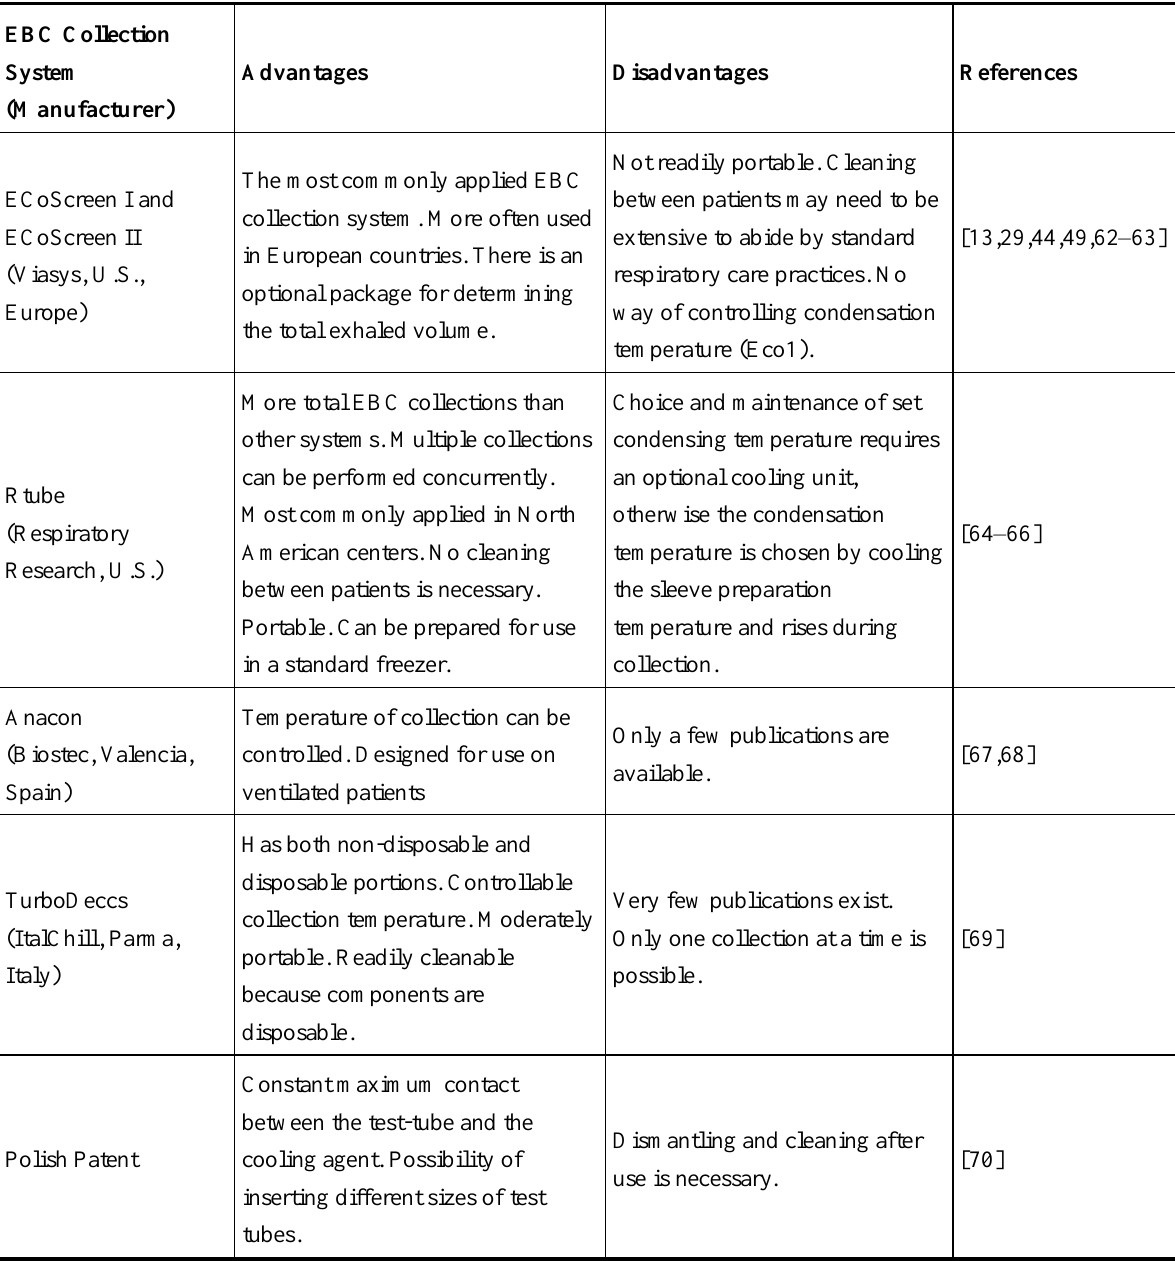
Table 1. Commercially available exhaled breath condensate collection